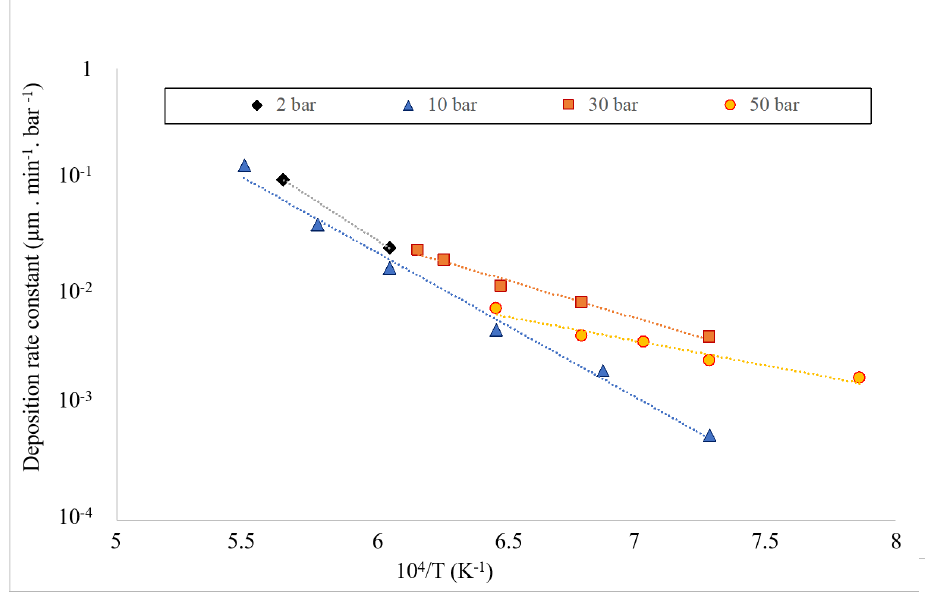
Figure 5. Arrhenius plots of the reaction rate for 4 different